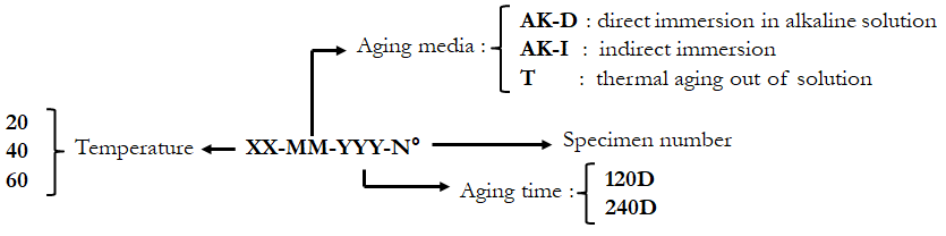
Figure 8. Nomenclature of the different aging protocols.